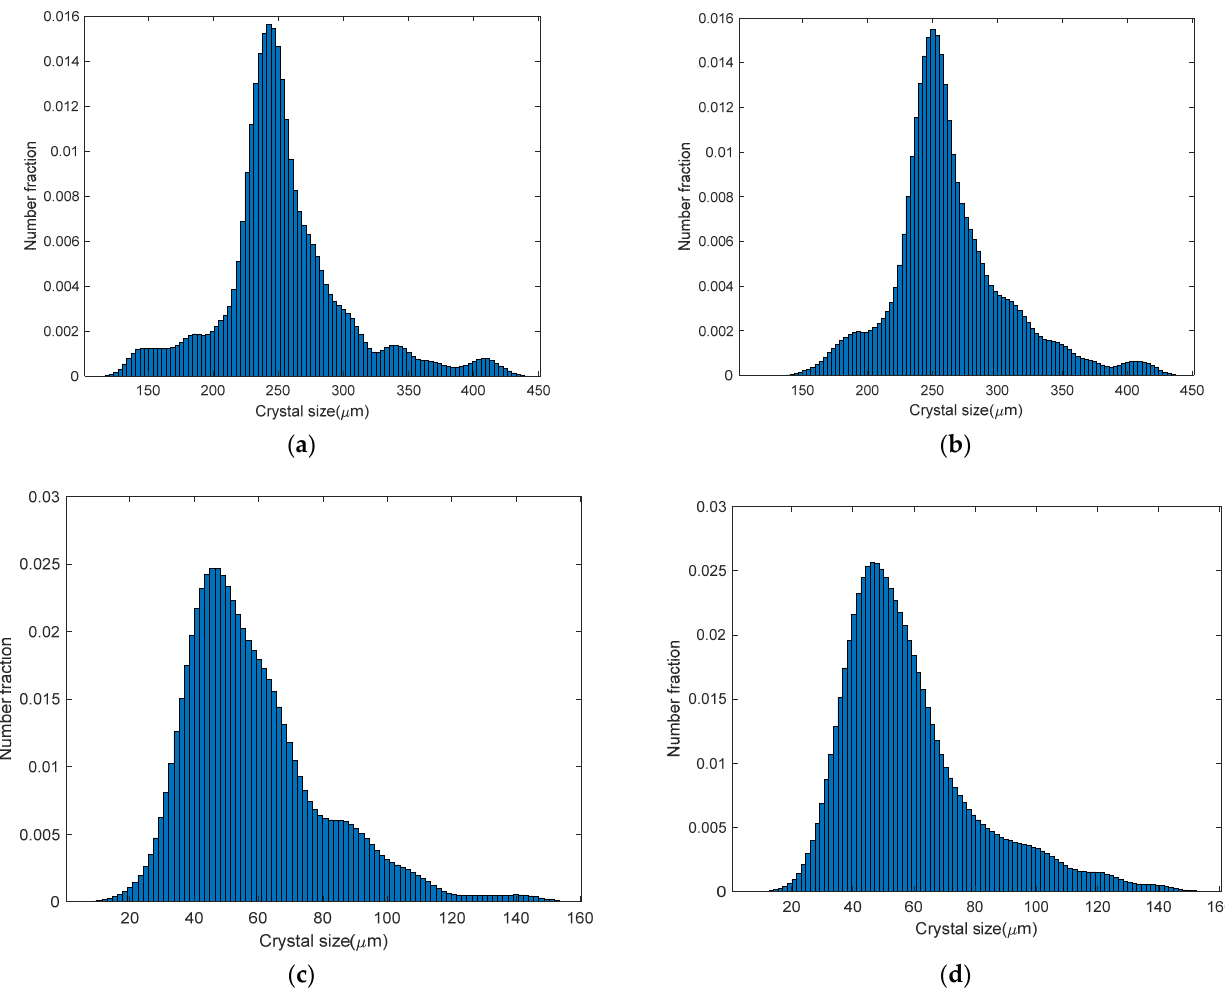
Figure 8. Comparisons between online and offline results of LGA crystal products: ( a ) histogram with the online measurement for LGA length; ( b ) histogram with the offline measurement for LGA length; ( c ) histogram with the online measurement for LGA width; ( d ) histogram with offline measurement for LGA width.